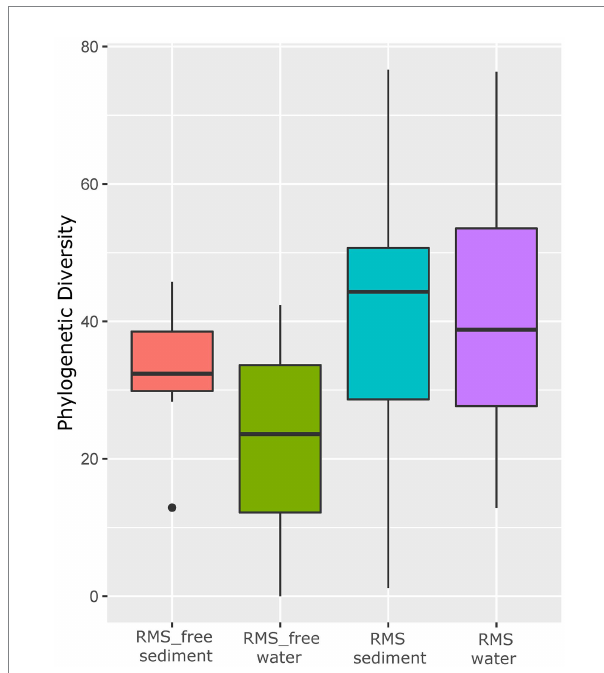
FIGURE 2 Alpha diversity based on Faith PD metric. Samples are grouped by “Condition_Source”, representing the combination of sample source (sediment or water) and tank condition (RMS-free or with fish affected by